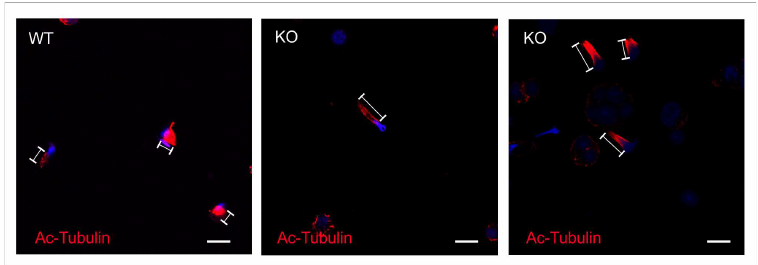
Figure 6. The manchette is abnormally elongated in Spag17 knockout mice. Germ cells were stained with anti-acetylated α -tubulin antibody to visualize manchette microtubules. The distance from the perinuclear ring to the caudal side of the head is longer in the knockout mice. WT, wild-type; KO, knockout. Scale bar = 10 µ m.